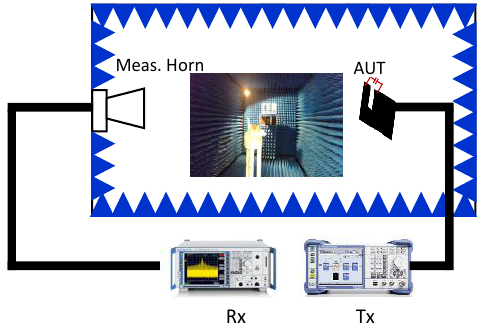
Figure. 14. Measurement setup around the anechoic chamber